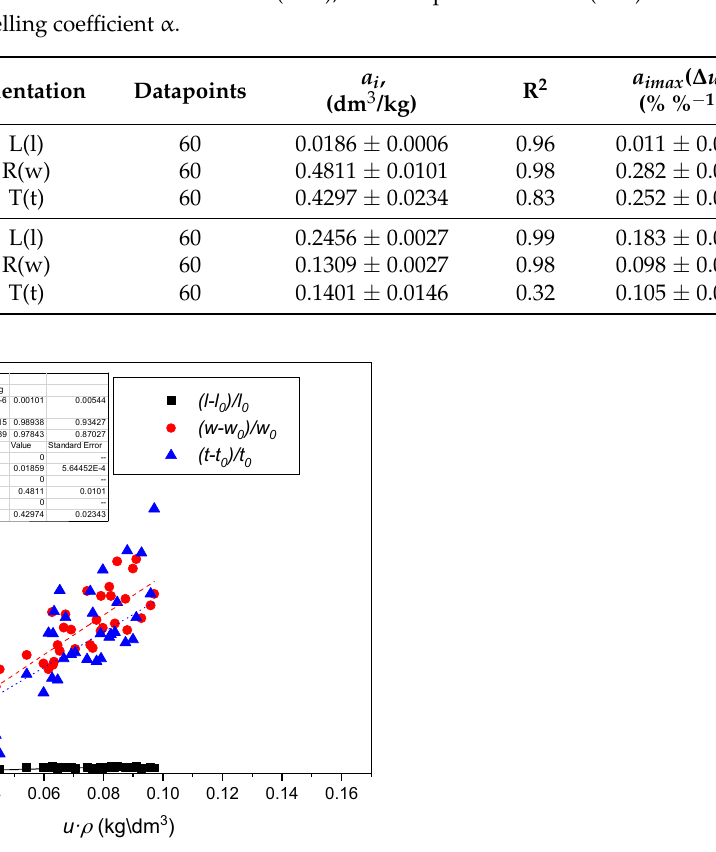
Table 2. Linear regression coefficients of normal (n.w.), and compression wood (c.w.) from Equa-